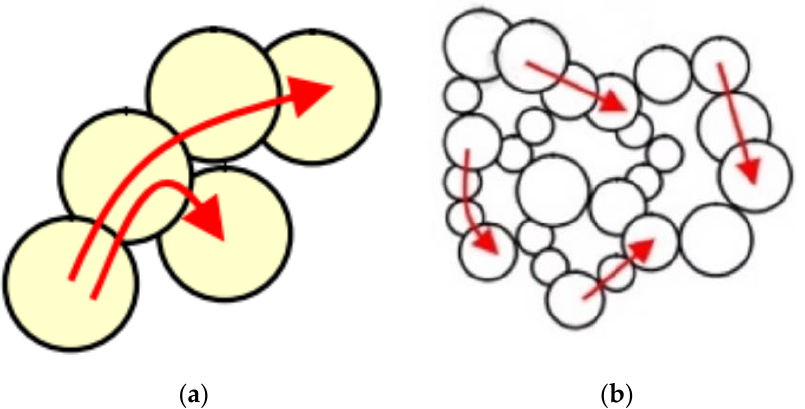
Figure 6. Solid thermal conductivity: ( a ) General porous materials; ( b ) Aerogel nano-porous mate- rials.